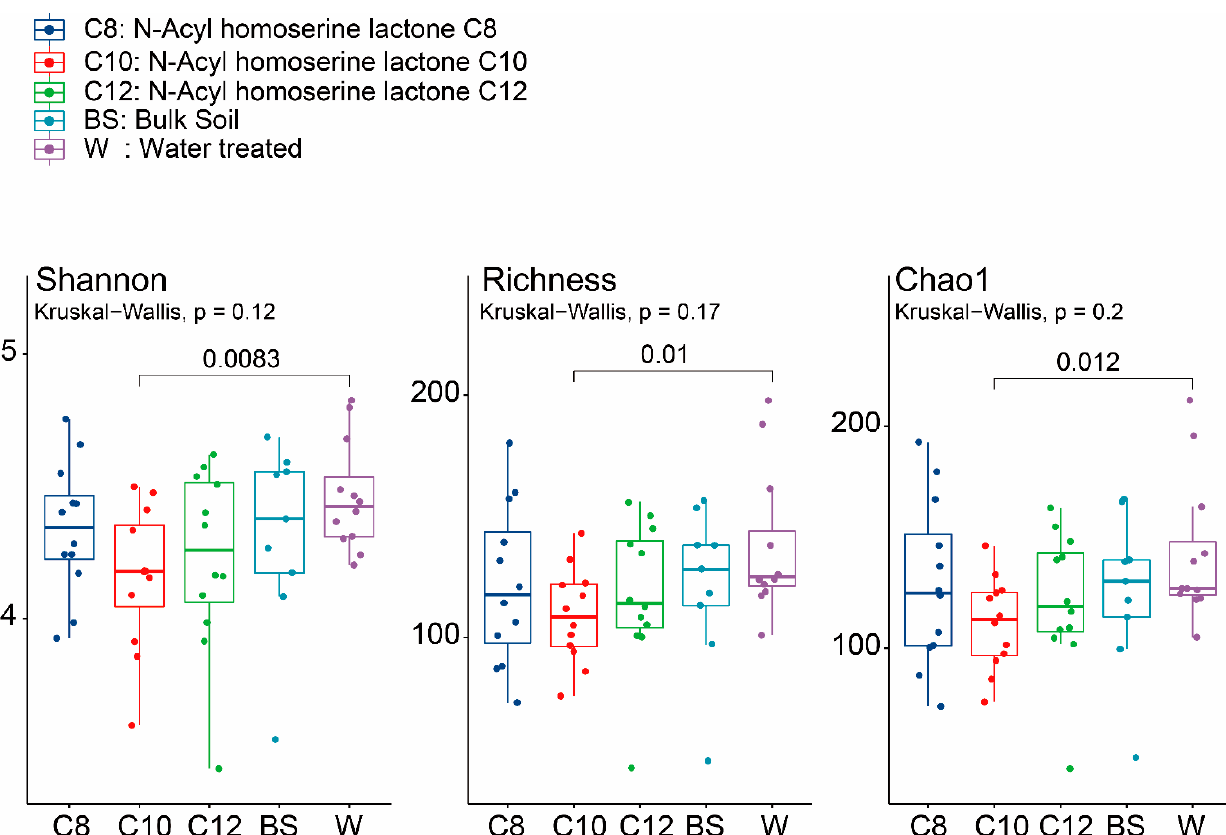
Figure 3. Total alpha diversity of soil microbial communities of the continuously mono-cropped treated with different moieties of acyl-homoserine lactones using Shannon, Richness, and Chao1 indices. The dark blue color shows the total alpha diversity for the C8 samples, while the red, green, light blue, and purple signify the C10, C12, BS, and W samples, respectively. The significance values were generated according to one-way ANOVA with Duncan’s multiple range test values ( p < 0.05).